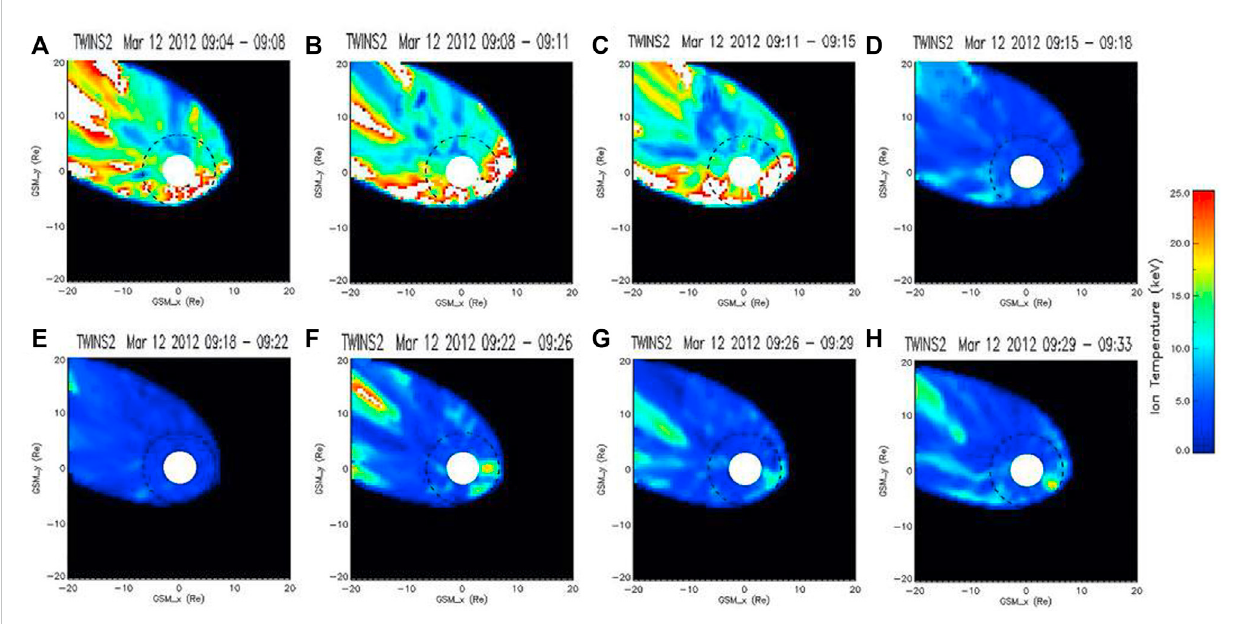
FIGURE 6 FromAdewuyietal.(2021). (A – H) :TWINSENAimagingusedtoplotiontemperaturemaps(color)in2Ddowntailovertime.WhitecircleisEarth, x -axisis X-GSM, y -axis is Y-GSM. Magnetotail fl ow channels appear before the sudden stormcommencement (SSC), indicating the importance of mesoscale injections to the inner magnetosphere at SSC. ASI data (shown in Adewuyi et al. (2021)) was also mapped to the tail, showing a similar trend in the